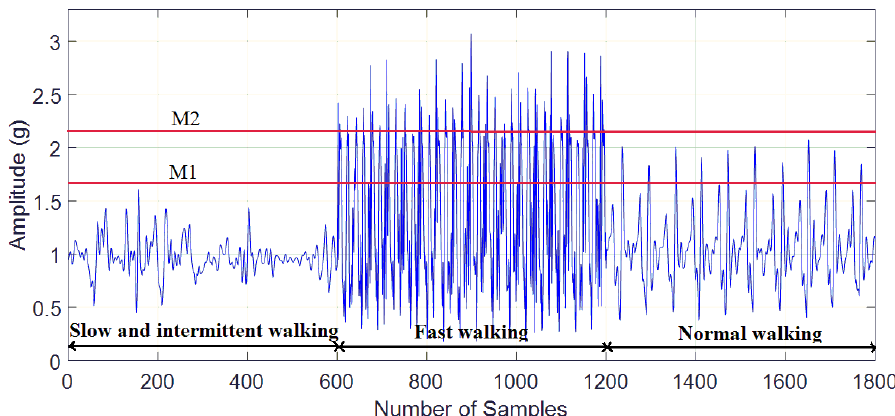
Figure 3. Acceleration magnitude of three different kinds of walking.